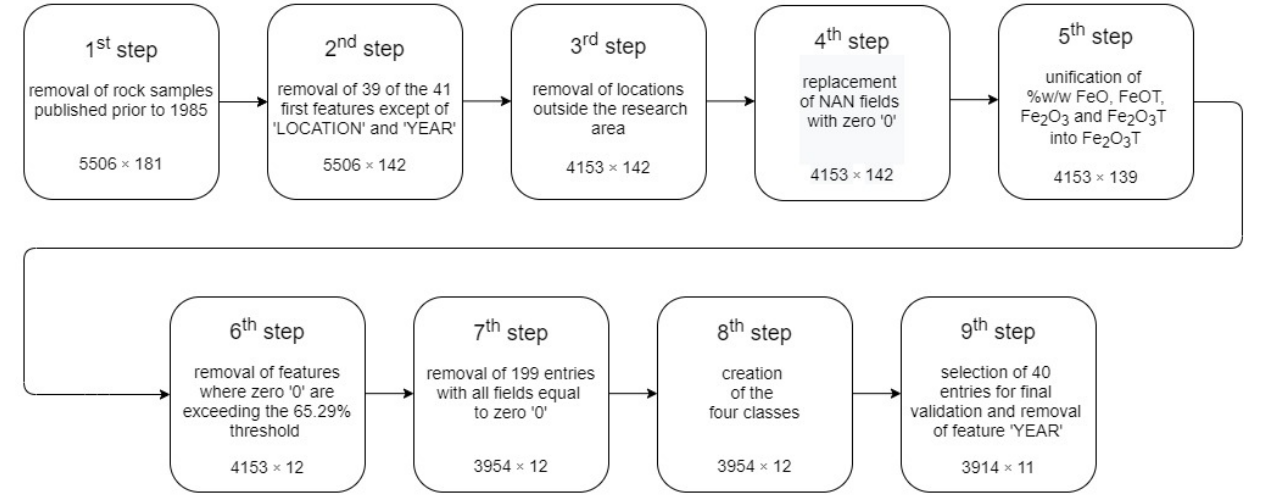
Figure 4. Block diagram of the data preparation steps.